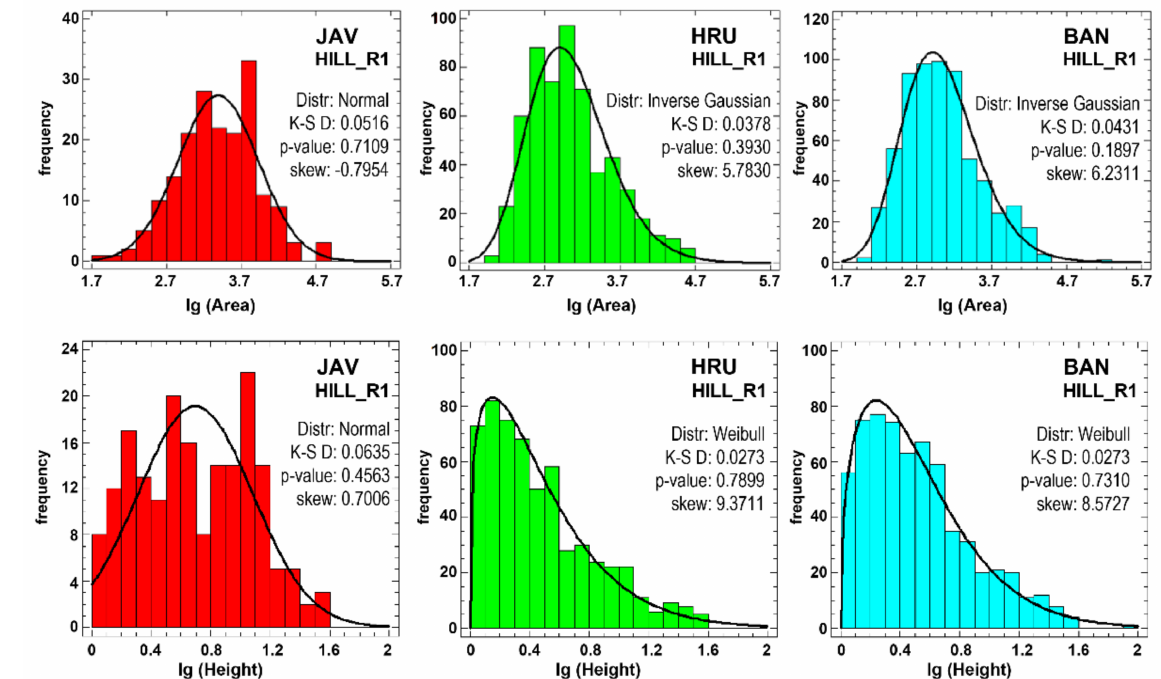
Figure 7. Empirical distributions and fitted theoretical distributions of hill properties (area and height). Note that feature properties are logarithmically transformed on the x-axis. JAV: Javorniki; HRU: Hrušica; and BAN: Banjšice. K-S D refers to the D-value of the Kolmogorov–Smirnov tests. p -values higher than 0.05 testify that the fitted distribution cannot be rejected. Skew refers to the standard skewness of the distribution.